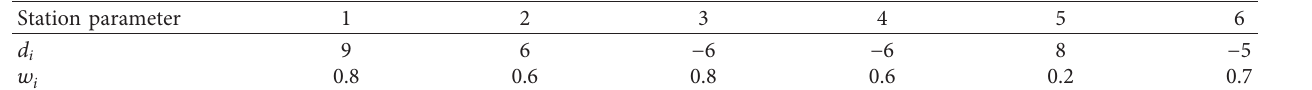
Table 10: Parameter setting.